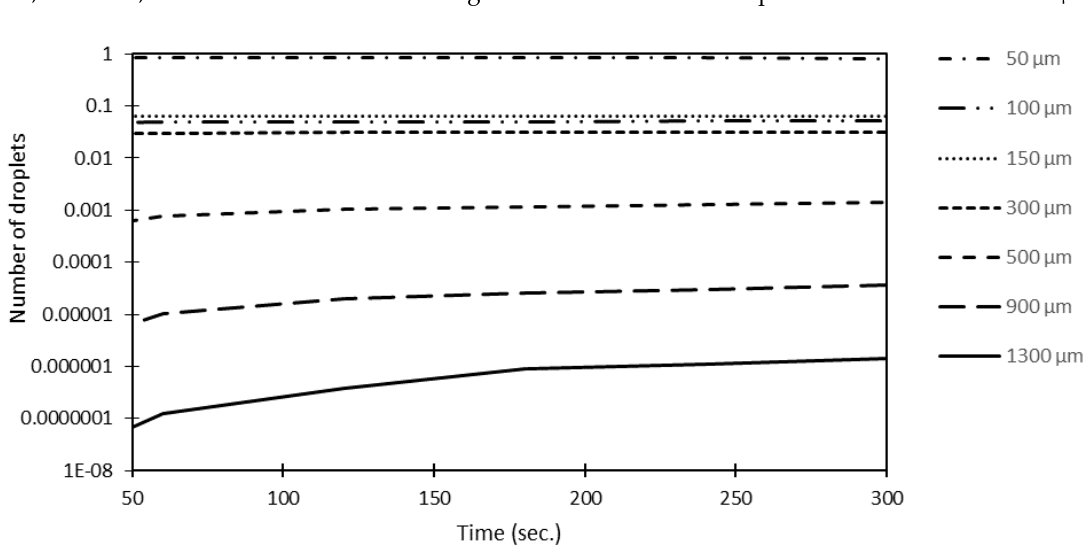
Figure 4. Number fraction distribution of different-sized droplets inside the settler.